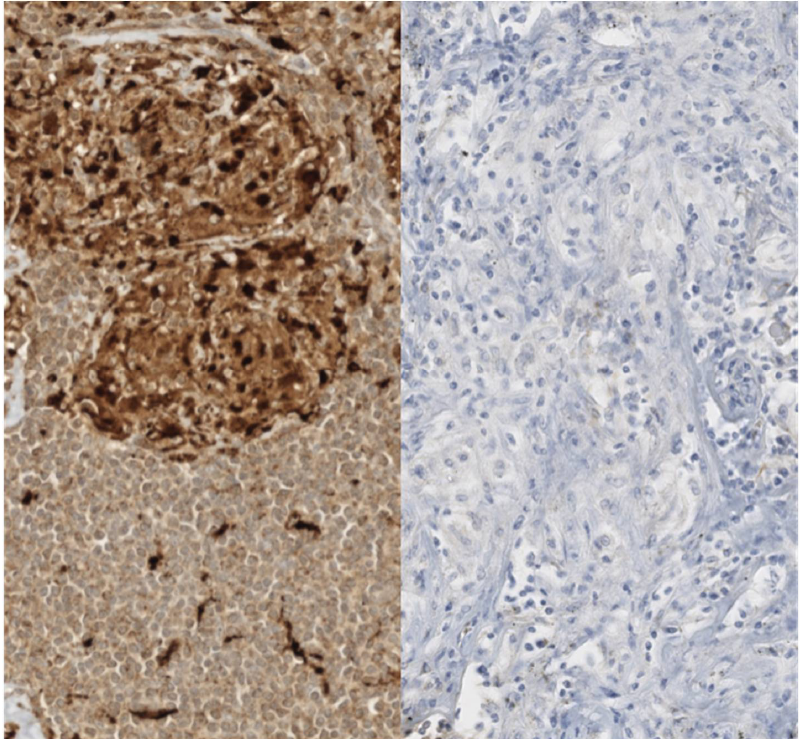
Figure 4. Immunohistochemical aspects of sarcoid granulomas. The histiocytes constituting sar-